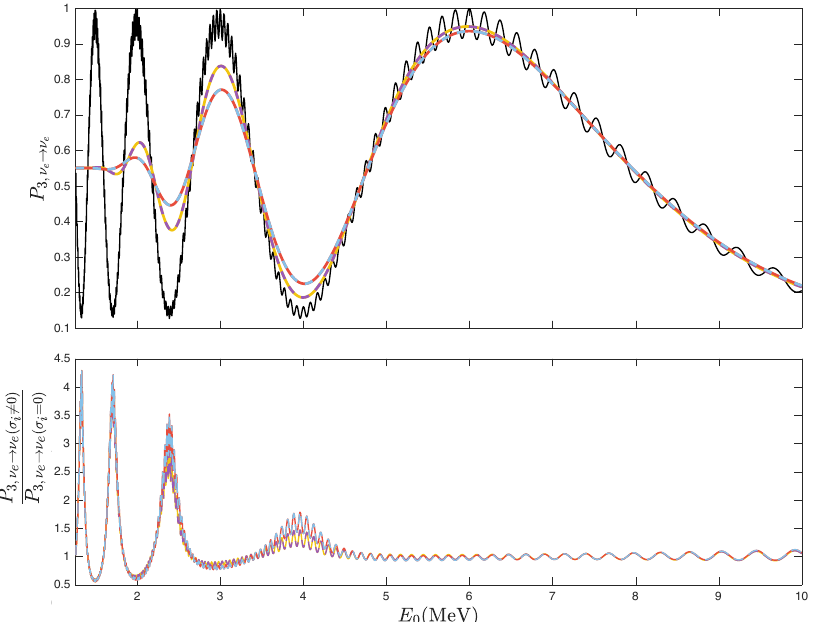
Figure 6 . Three flavor FTP spectrum from electron neutrino to electron neutrino on the mea- surement layer at L = 200 km (this distance is chosen such that decoherence effects are visible in 0 this energy range for some reasonable uncertainties). The black line represents completely coherent FTP, and the coloured lines all have σ = 0 . 4 MeV and σ is negligible compared to σ . We have ¯ p ¯ x L σ L = 0 m, σ E = 0 MeV for the yellow line, σ L = 5 m, σ E = 0 MeV for the purple line, σ L = 0 m, √ √ σ E = 0 . 1 E 0 MeV for the red line, and σ L = 5 m, σ E = 0 . 1 E 0 MeV for the blue line. Here σ L is chosen according to a typical reactor core size, σ is a typical detector resolution and σ is taken E ¯ p at a value such that it is comparable with σ E